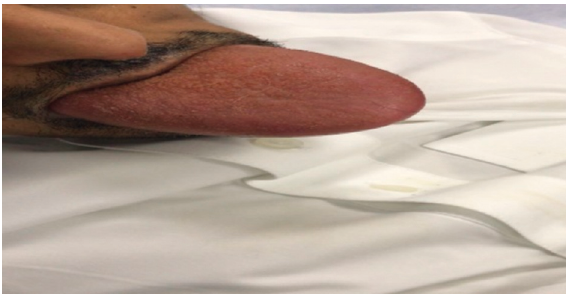
Figure 1: Clinical photograph of the patient in hospital following presentation with an anterior tongue protrusion beyond the lips.